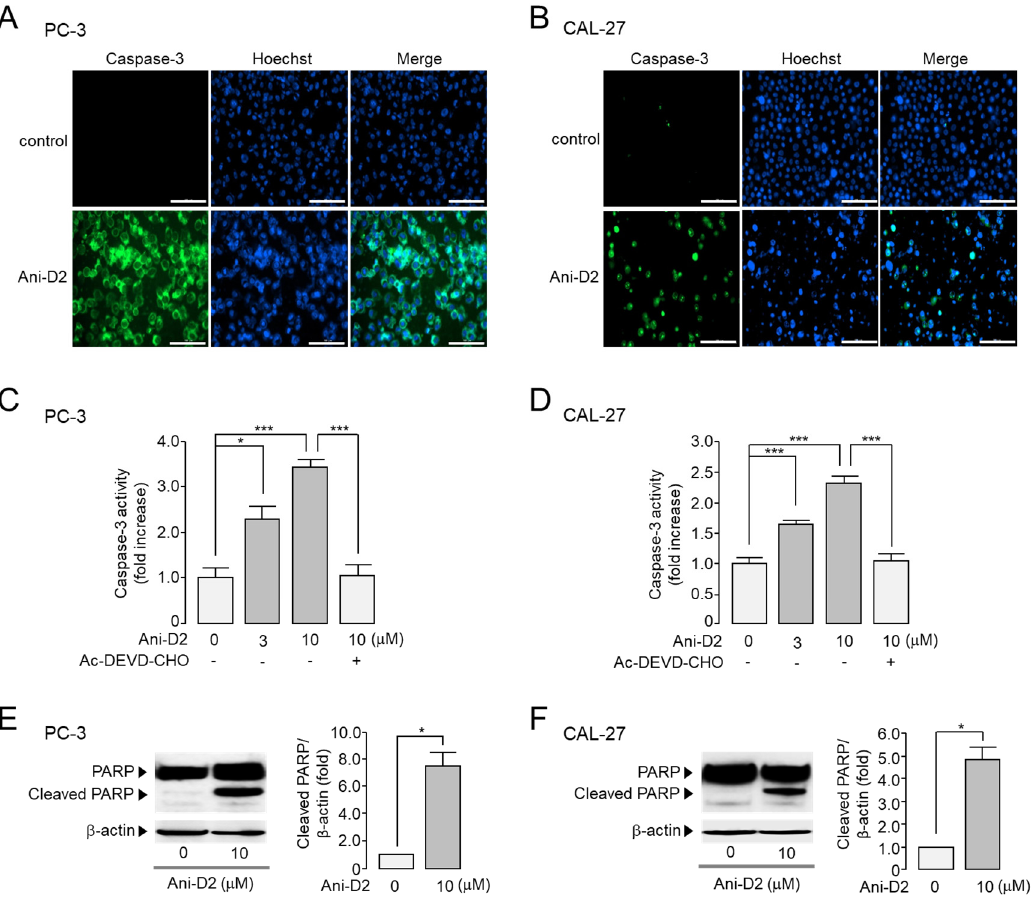
Figure 7. Effect of Ani-D2 on caspase-3 activity and cleavage of PARP in PC-3 and CAL-27 cells. ( A , B ) Images were taken after 24 h incubation with Ani-D2. Caspase-3 substrate (green, 2.0 μ M) and Hoechst 33342 (blue, 1 μ M) were treated for 20 min prior to image acquisition. The white bar represents 200 μ m. ( C , D ) Cells were cultured with Ani-D2 at the indicated concentrations for 24 h, then 2 μ M of caspase-3 substrate was treated for 20 min. Caspase-3 activity was inhibited by 10 μ M of Ac-DEVD-CHO (mean ± S.E., n = 3–4). ( E , F ) Cells were cultured with 10 μ M of Ani-D2 for 24 h, and expression level of PARP, cleaved PARP, and β -actin were measured by immunoblot analysis (mean ± S.E., n = 3). * p < 0.05, *** p < 0.001.